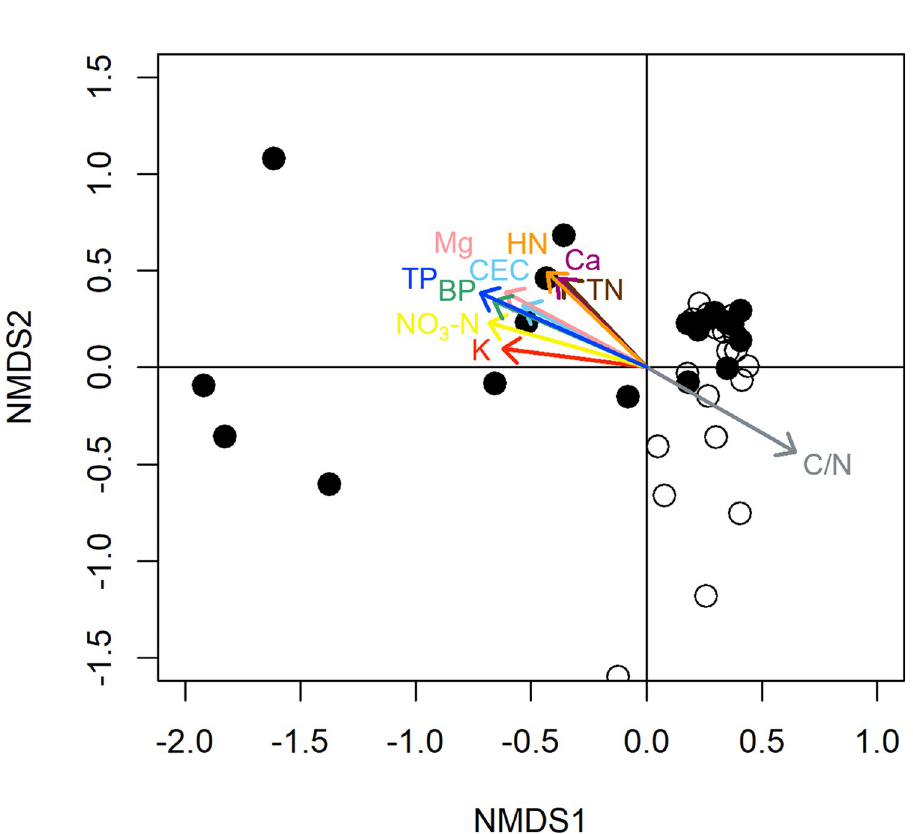
Fig 3. Relationship between species composition in the two pastures and soil chemical properties in 2019. Non- metric multi-dimensional scaling (NMDS) ordination of plant species composition in the improved (filled circle) and native (open circle) pastures in 2019. The vectors represent the significant ( p < 0.05) chemical properties associated with the species composition. Abbreviations: NMDS1 and NMDS2, axes 1 and 2 for the NMDS, respectively; TN, total N, HN, hot-water-extractable N; BP, Bray II P; TP, Troug P; CEC, cation exchange capacity; Ca, exchangeable Ca; Mg, exchangeable Mg; and K, exchangeable K.